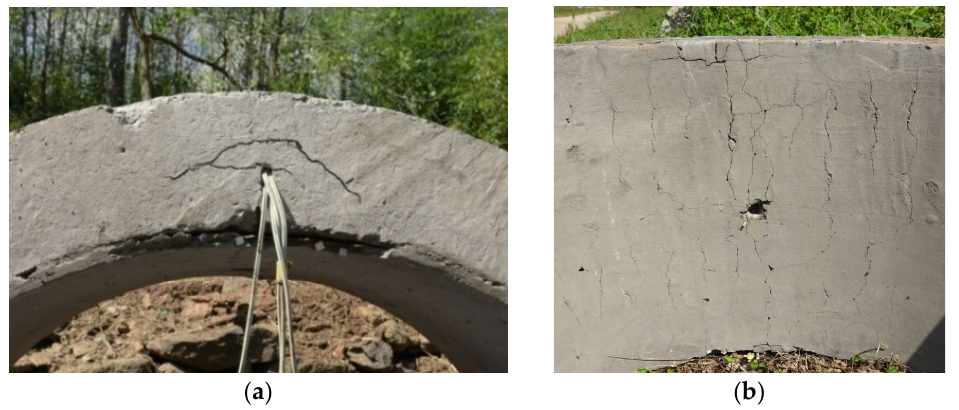
Figure 7. Damage of composite reinforced arch against blast.